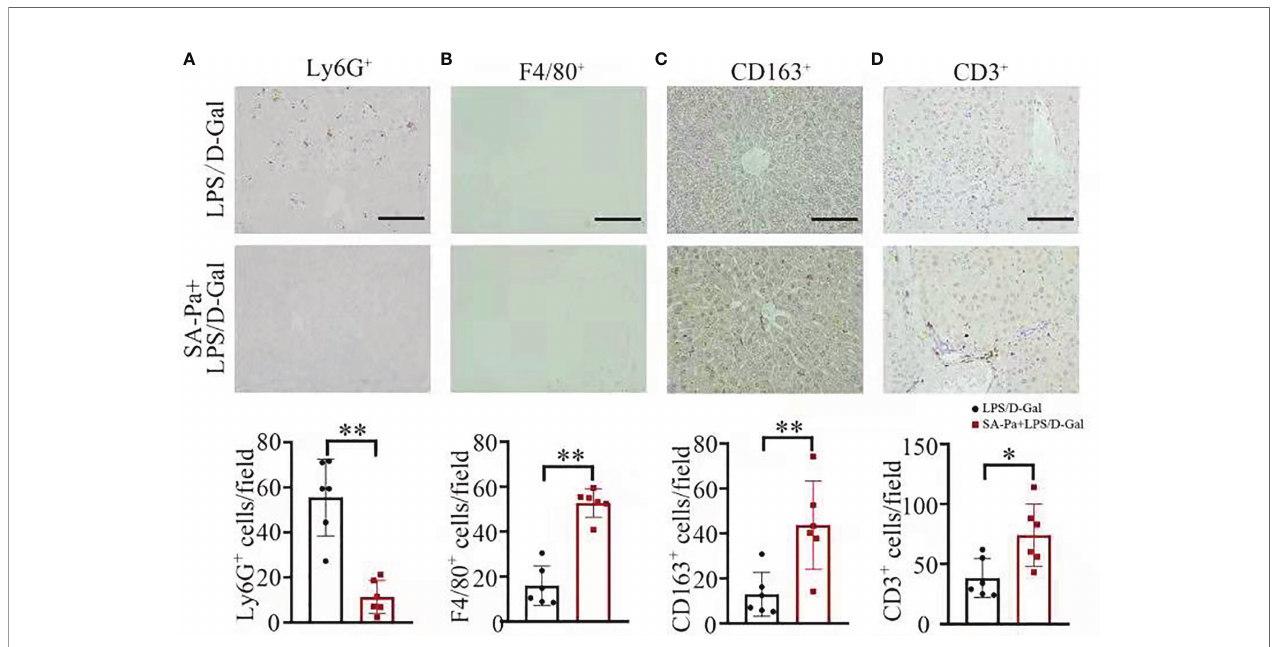
FIGURE 4 | SA-Pa affected the in fi ltration of different immune cells after the LPS/D-Gal injury. (A – D) Representative pictures for Ly6G + , F4/80 + , CD163 + , and CD3 + staining in the liver section (top) and quantitative results (bottom) (LPS/D-Gal group, n = 6; SA-Pa group, n = 6; *p <0.05; ** p < 0.01; scale bar = 100 m